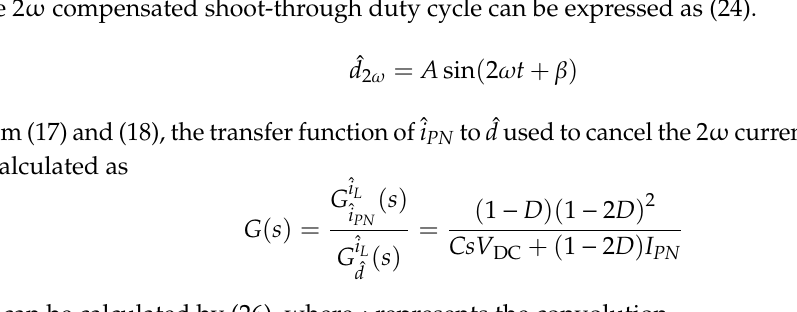
( b ) Figure 4. Phasor diagram of double-frequency ( 2ω) power flows with the CMS ( a ) and RVCMS ( b ) .